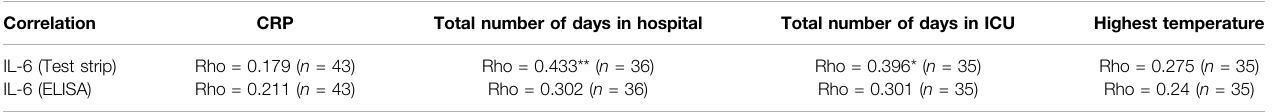
TABLE 2 | Correlation between IL-6 and other clinical information based on both test strip and ELISA results. Correlation CRP Total number of days in hospital Total number of days in